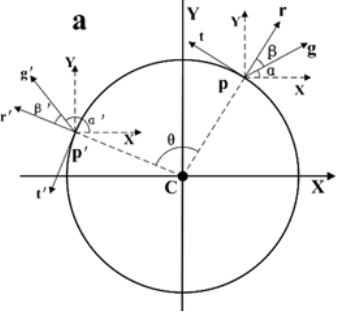
Figure 2. Definition of local coordinate system for each search window in the SRHOG method